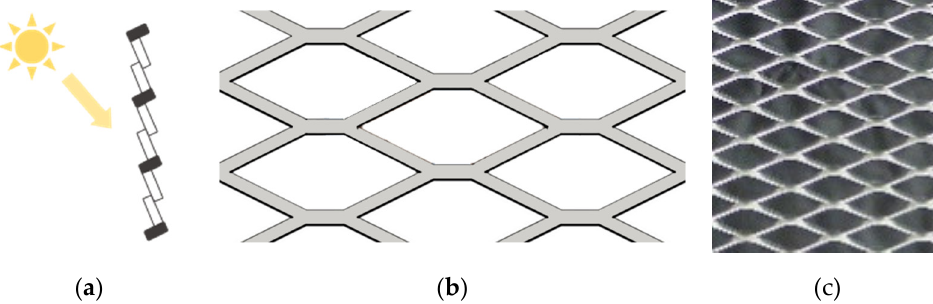
Figure 4. Schematic diagram of expanded metal mesh. ( a ) Section (the opening of the hole facing down); ( b ) Plan; ( c ) Photo.